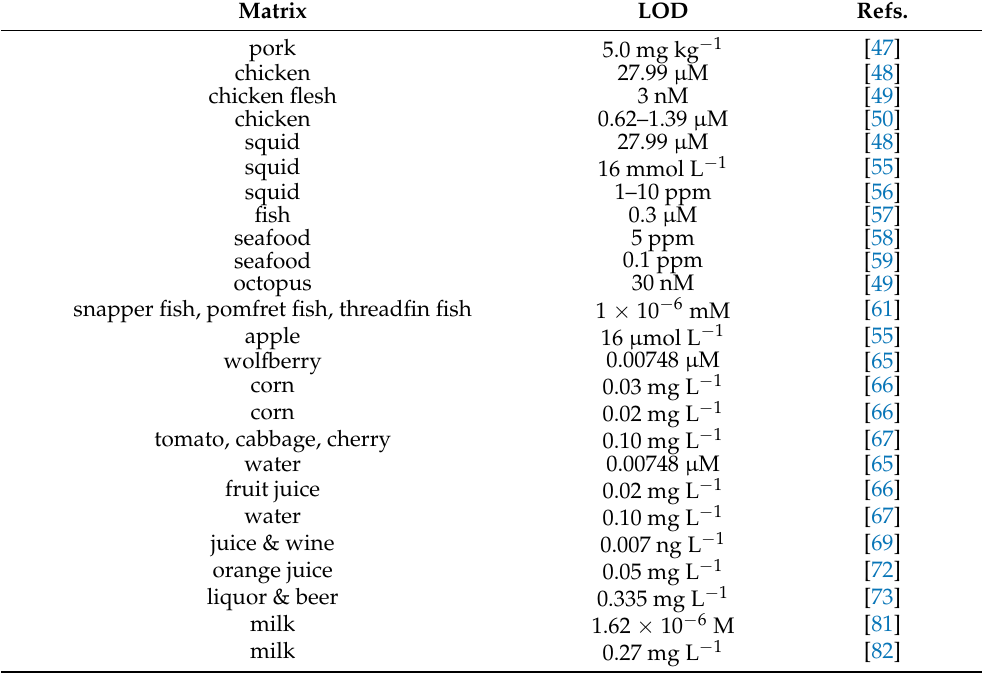
Table 7. Resume of the different LODs determined in the different investigated studies. The ta- ble is independent in relation to the analytical methodologies and the technologies used in the different